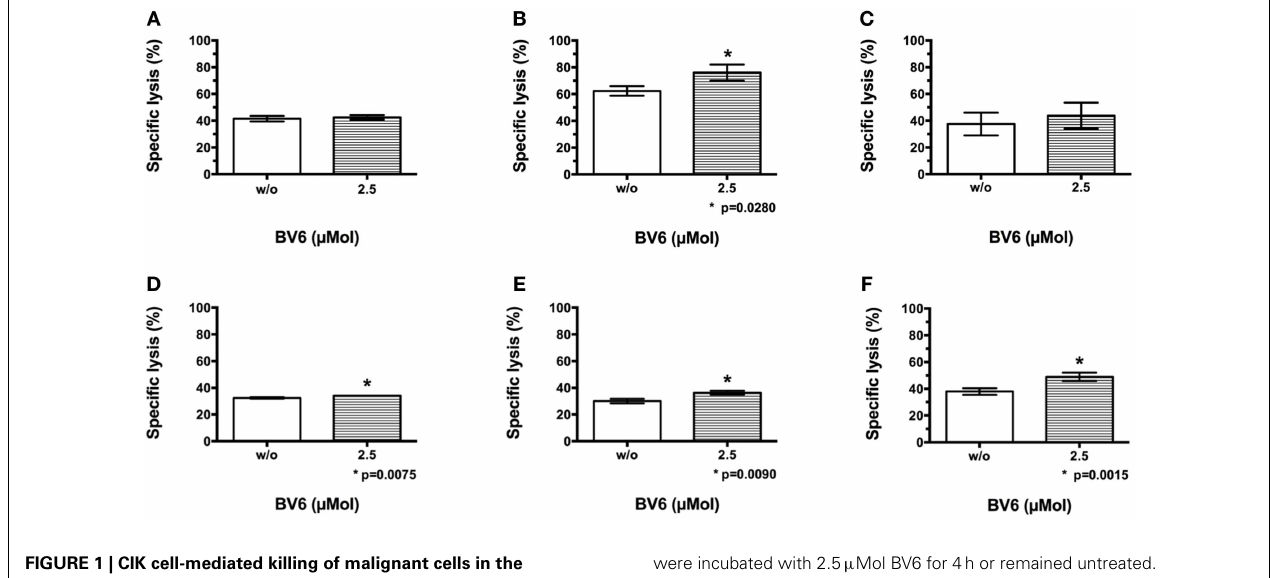
FIGURE 1 | CIK cell-mediated killing of malignant cells in the presence of BV6 .The potential of BV6 to increase CIK cell-mediated killing of hematological (H9,T cell lymphoma (A) ;THP-1, subtype M4 acute myeloid leukemia (B) ;Tanoue, precursor-B acute lymphoblastic leukemia (C) ) and solid tumor targets (RH1, Ewing sarcoma (D) ; RH30, alveolar rhabdomyosarcoma (E) ;TE671, embryonal rhabdomyosarcoma (F) ) was analyzed by europium release assay.Therefore, target cells